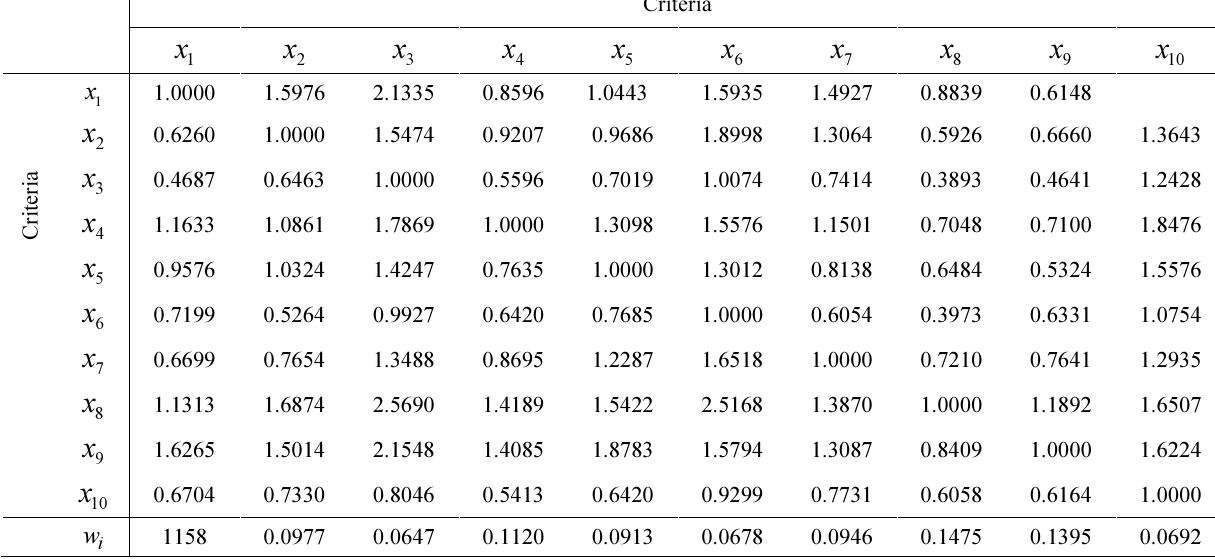
Table 2. Weights of the criteria w j